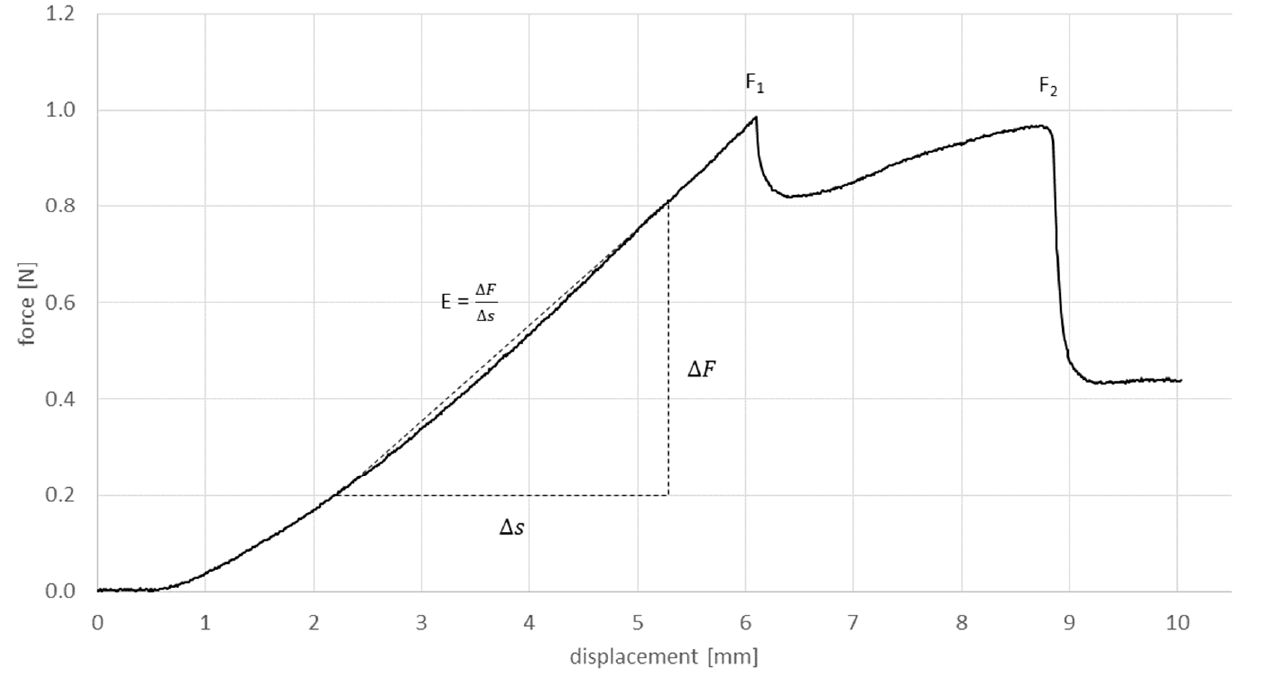
Figure 5. Schematic visualization of the evaluated values extracted from the force displacement graphs of the performed tests. E as the gradient of the change in force over the change in place. F 1 as the first force peak and F 2 as the following force